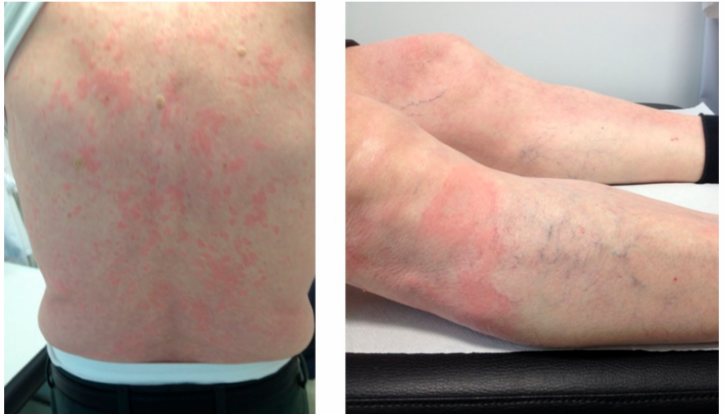
Figure 2. A 78-year-old patient with urticarial lesions, fever, mild leukocytosis, elevated CRP, and positive immunofixation for IgM kappa. The patient was diagnosed with Schnitzler